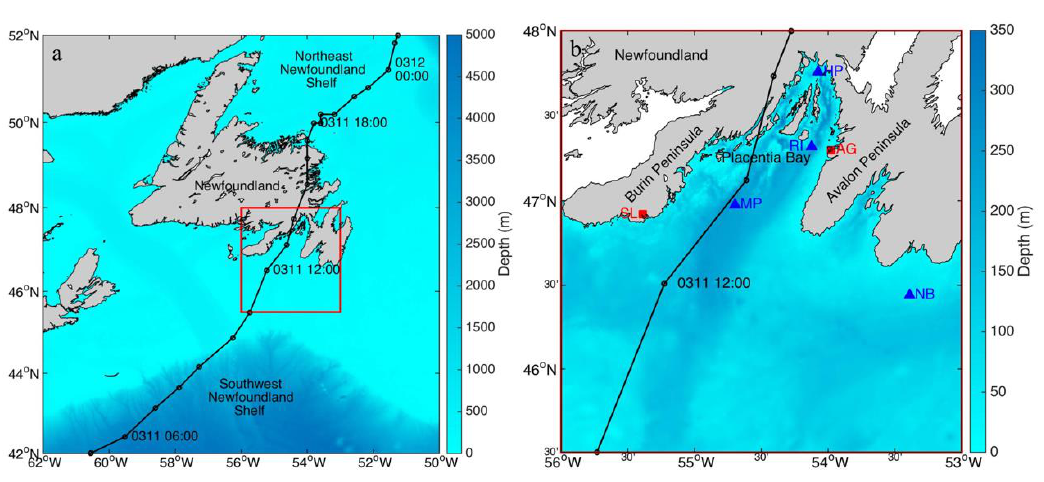
Figure 1. ( a ) Map showing the study area. The black line is the track of the extratropical cyclone during 11~12 March 2017 and the background color shows the bathymetry of the region. The red box shows the model domain. ( b ) Map of the model domain. Red squares are tide-gauge stations (SL, St. Lawrence; AG, Argentia) and the blue triangles indicate locations of observation buoys (HP: Head of Placentia Bay; RI: Red Island Shoal; MP: Mouth of Placenta Bay; NB: Nickerson Banks).